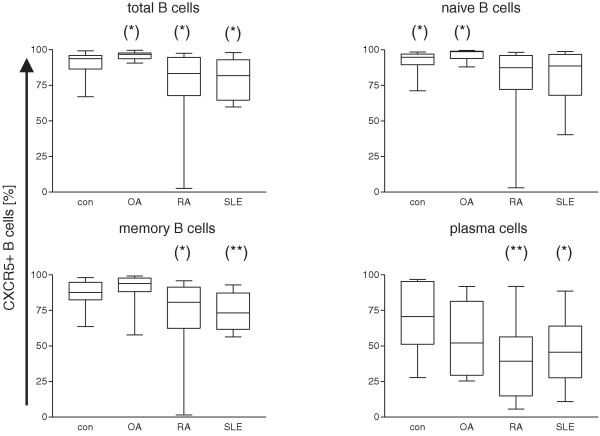
Chemokine receptor CXCR5+ expression on B cell subpopulations. The percentage of total B cells, naive B cells, memory B cells and plasma cells expressing CXCR5+ are given. Box plots show the median values, 25th and 75th quartile and the range of values. Significant differences from controls are shown (*P < 0.05, **P < 0.005).